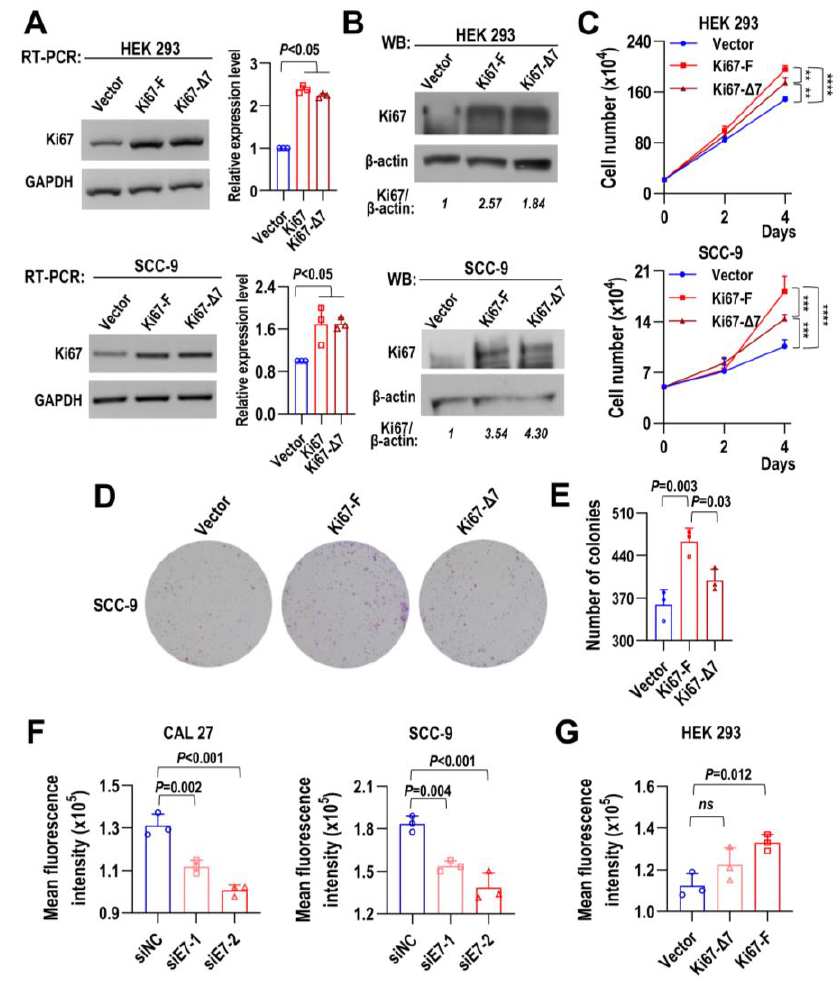
Figure 4. Full-length Ki67 with exon 7 promotes HNSCC cell proliferation, colony formation, and intracellular ROS production. HEK 293 and SCC-9 cells were stably overexpressed with Ki67 full- length isoform (Ki67-F), Ki67 without exon 7 isoform (Ki67- ∆ 7), and control vector (Vector). ( A ) The overexpression efficiency of Ki67-F and Ki67- ∆ 7 in both HEK 293 and SCC-9 cells were demonstrated by RT-PCR. GAPDH served as a loading control. The histograms summarize the statistical analysis. ( B ) Western blot confirmed the overexpression of Ki67-F and Ki67- ∆ 7 in both HEK 293 and SCC-9 cells. β -actin served as a loading control. ( C ) Proliferation curves of HEK 293 and SCC-9 cells with Ki67-F and Ki67- ∆ 7 stably overexpression. HEK 293 cells (22 × 10 4 cells/well) or SCC-9 cells (5 × 10 4 cells/well) were seeded into 24-well cell culture plates. Cells were passed on Day 2. Cell numbers were counted on Days 2 and 4. ( D , E ) Effect of Ki67-F and Ki67- ∆ 7 overexpression on the clonogenic ability of SCC-9 cells. One thousand cells were seeded in each well of 6-well cell culture plates and cultured for eight days. Representative images are shown, and the histogram summarizes the numbers and statistical analysis of colonies. ( F , G ) The intracellular ROS production levels of cells. CAL 27 and SCC-9 cells were treated with siE7s and siNC twice as before, and HEK 293 cells were overexpressed with Ki67-F, Ki67- ∆ 7, and Vector. Cell intracellular ROS level was measured by flow cytometry. The histograms summarize the mean fluorescence intensity. All data are mean ± SD, n = 3. ** p < 0.01, *** p < 0.001, **** p <